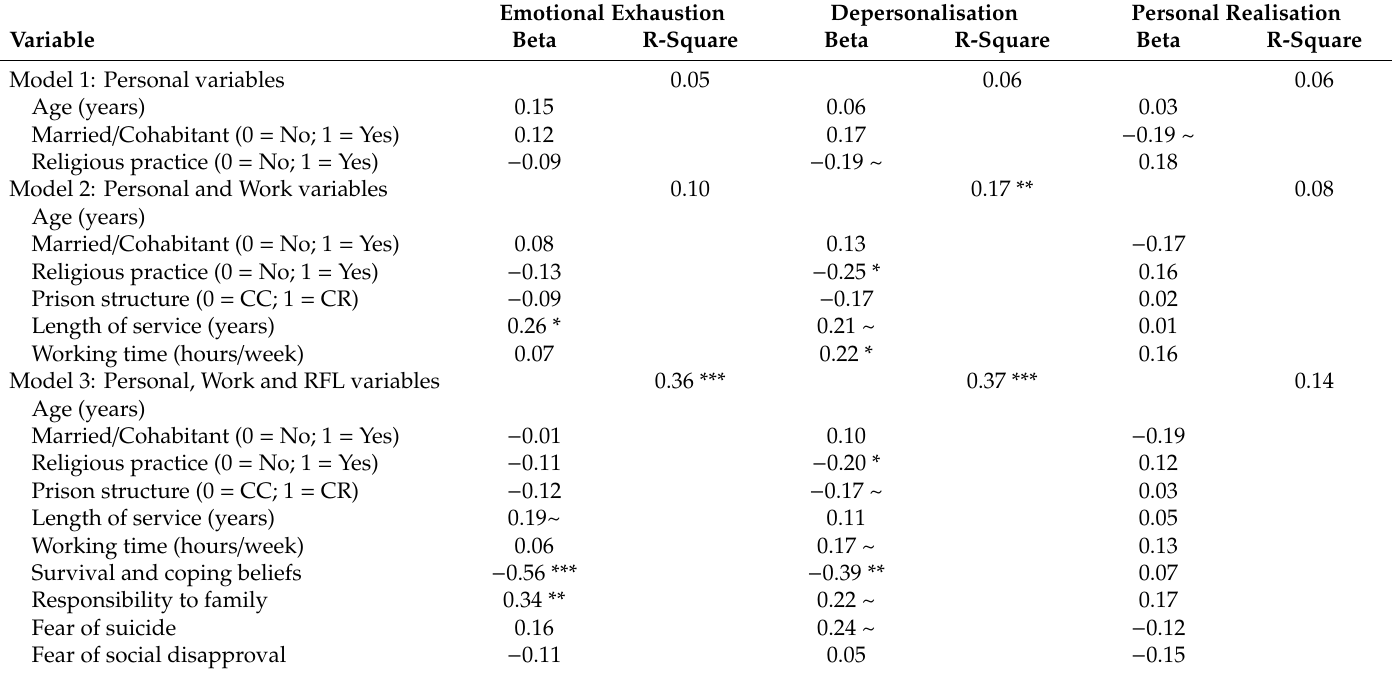
Table 3. Regression analyses results to evaluate the impact of personal variables, work variables and RFL variables on MBI subscales. Emotional